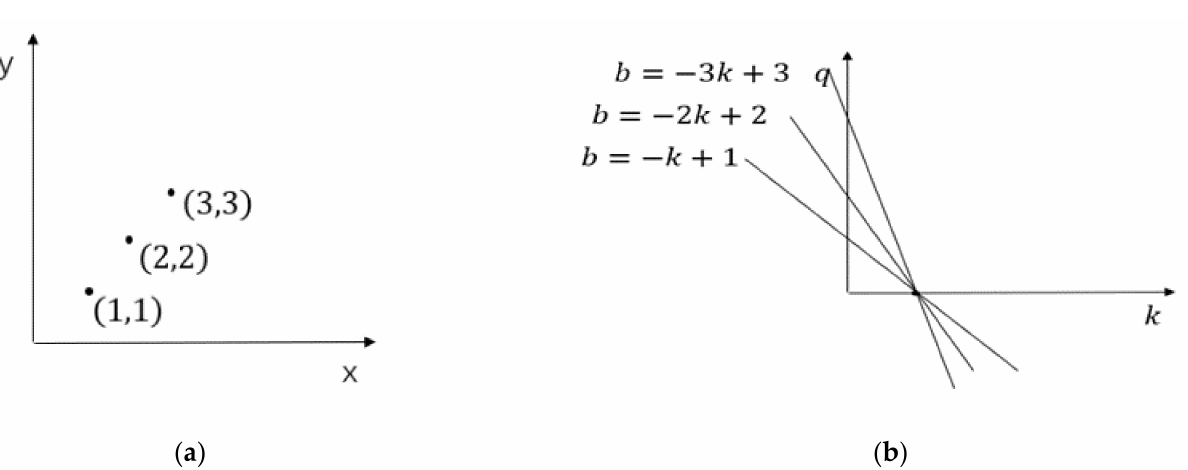
Figure 11. Before and after edge detection. ( a ) Image to be detected. ( b ) Edge detection renderings. The last step of edge detection also detected some interference factors; there is a need to further operate the image after edge detection to find the lane line. In most cases, the lane line is a straight line, so this paper uses Hough transform to extract the lane line. Input the two-dimensional image. In a Cartesian coordinate system, the function ex- pression of straight line is y = kx + b and the expression converted to the Hough coordinate system is b = − xk + y . As shown in Figure 12 below, a point on a straight line in a Cartesian coordinate system is transformed into a Hough space and is intersected at a point.